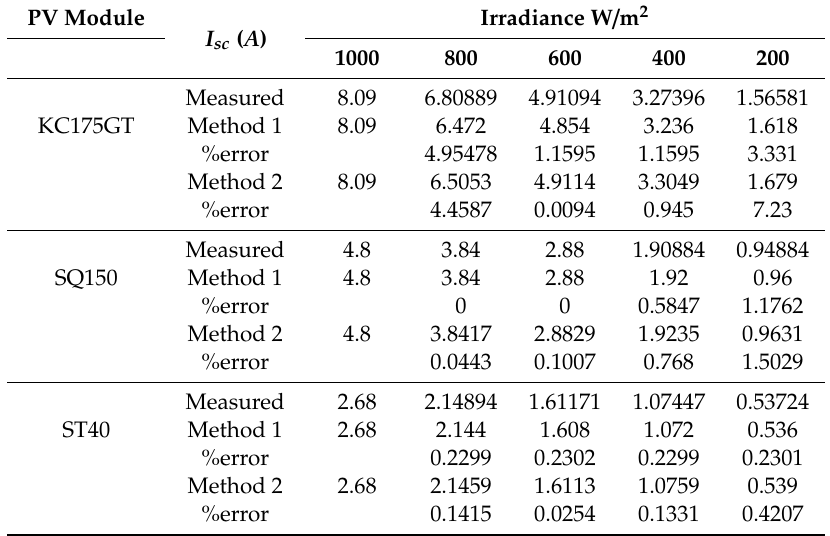
I sc (A) and the relative error.